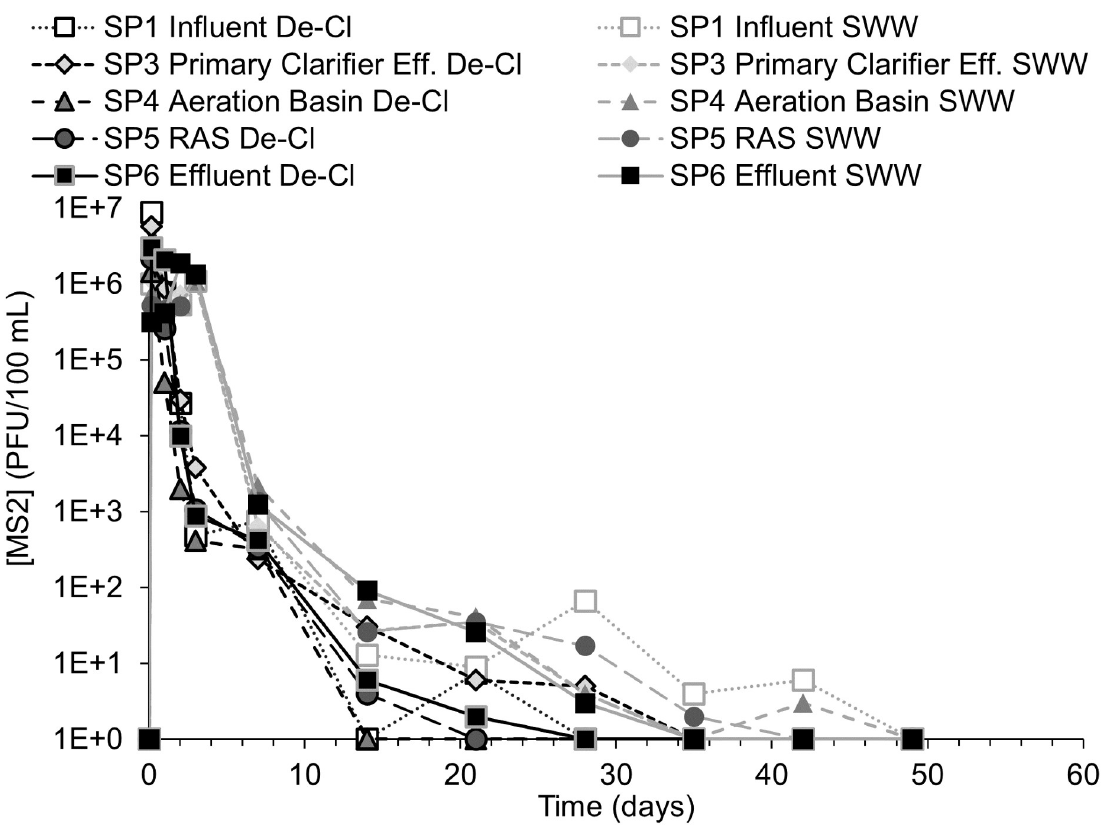
Fig 5. MS2 concentration response curves for Test 1 and 2. Concentration-time plot of individual sample ports over time for experiment 1 and experiment 2.